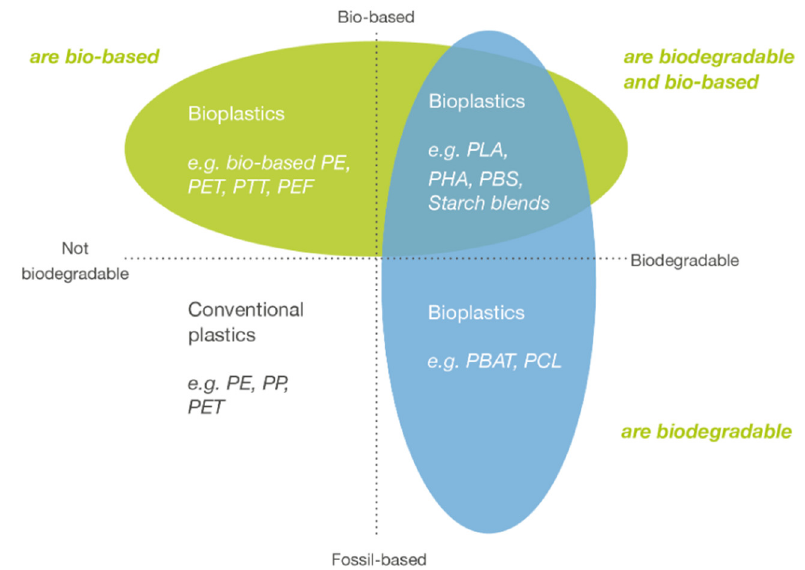
Figure 1. Schematic representation of bioplastics: on the x -axis is the biodegradability feature, on the y -axis is the origin of the monomer; reprinted with permission from ref. [11].